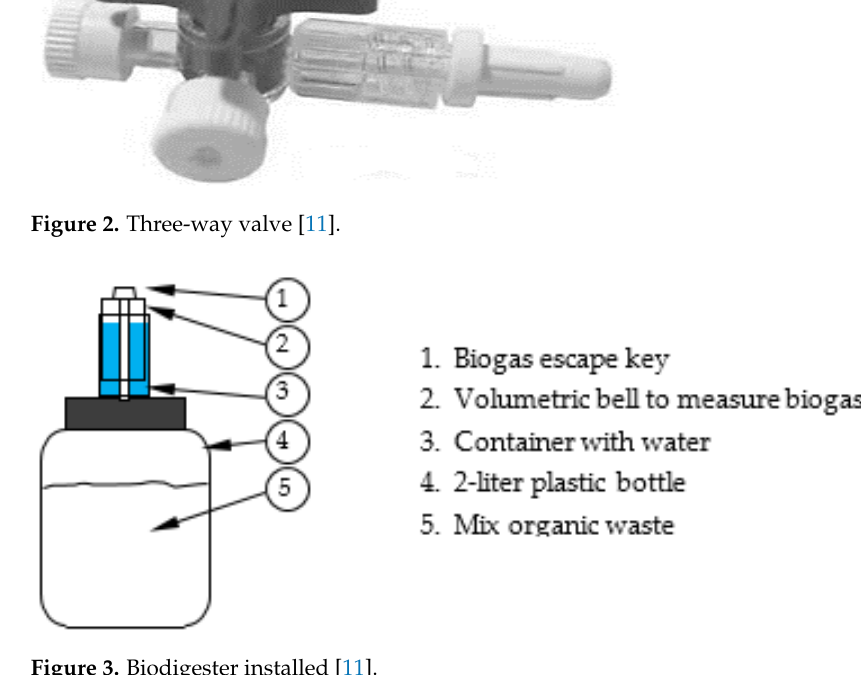
Figure 3. Biodigester installed [11].